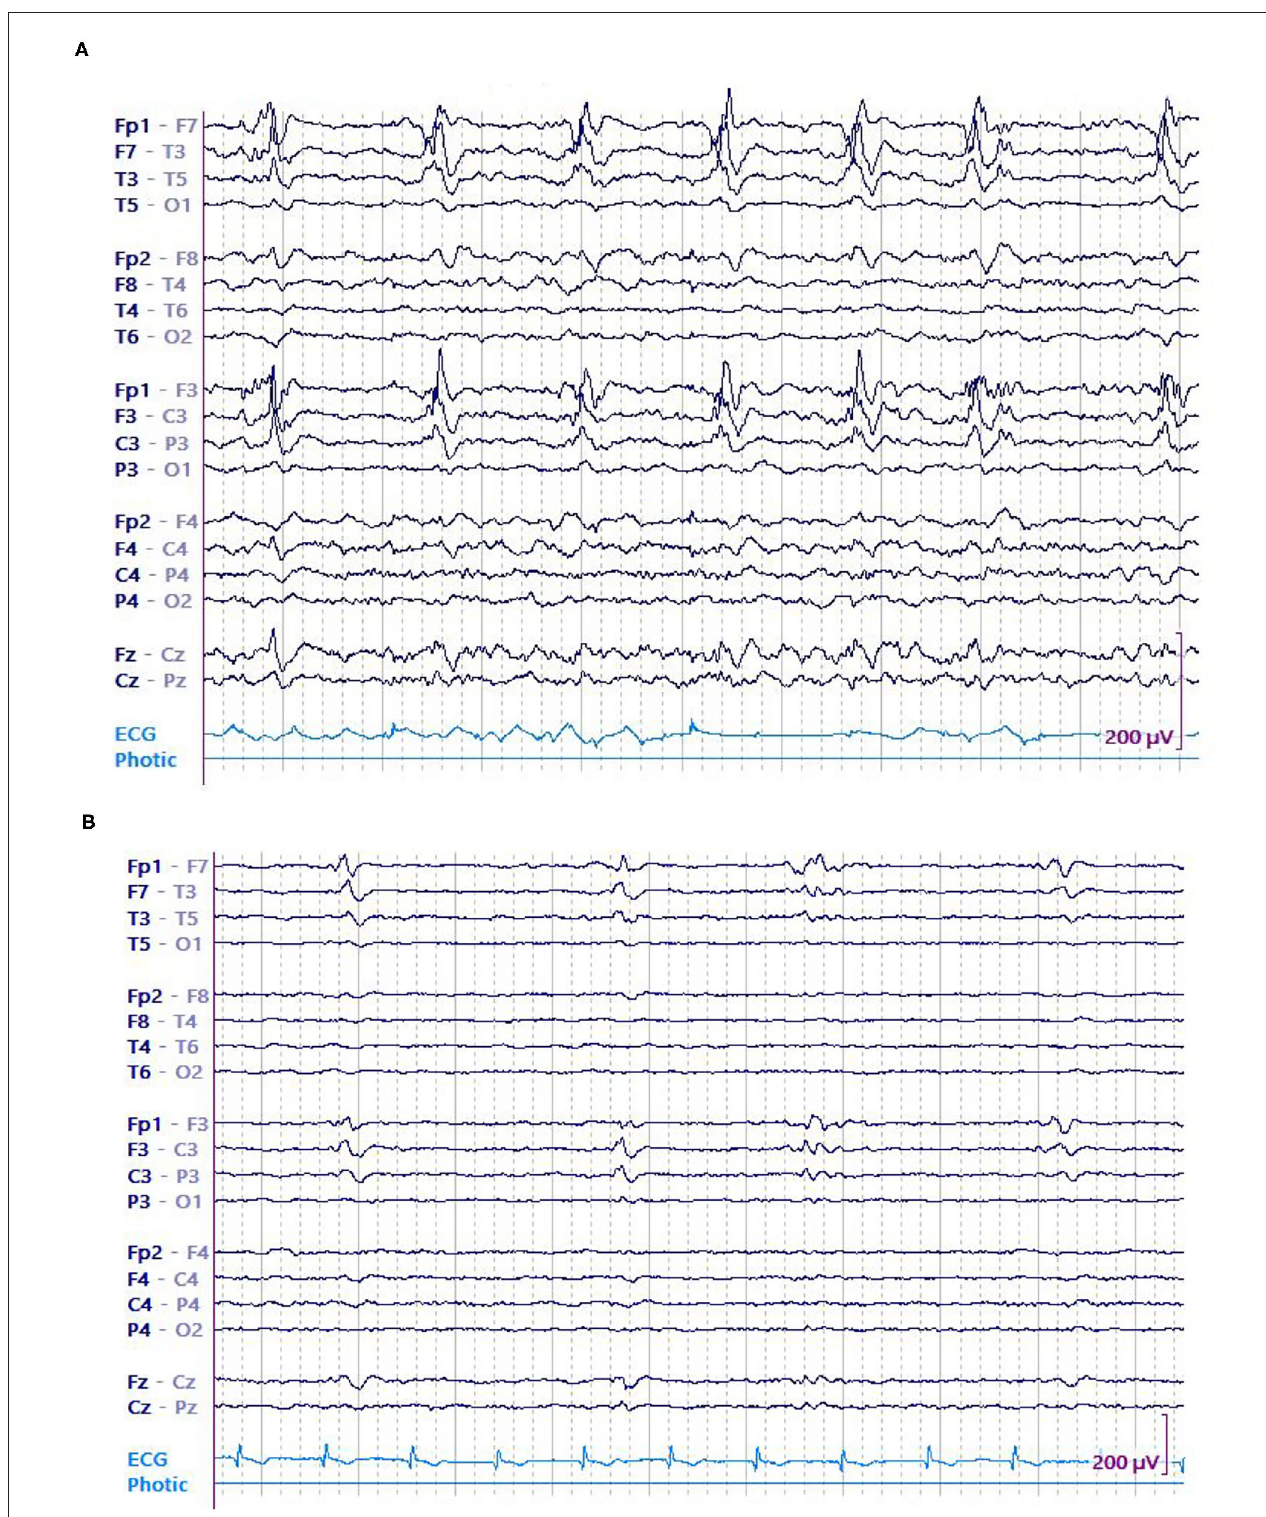
FIGURE 3 | A 74 y/o gentleman with history of left frontoparietal crani for resection of the tuberculum sella meningioma a month earlier presented with dysarthria and underwent continuous EEG (cEEG) monitoring. EEG showed continuous high amplitude left frontal LPDs occurring at 0.5Hz that evolved into recurrent left sided electrographic seizures. Patient was started on anti-seizure medications including levetiracetam, lacosamide, fosphenytoin, and clobazam. His seizures resolved eventually and LPDs decreased in amplitude concurrent with resolution of seizures. (A) LPDs in epoch with seizure. (B) LPDs in epoch without seizure.